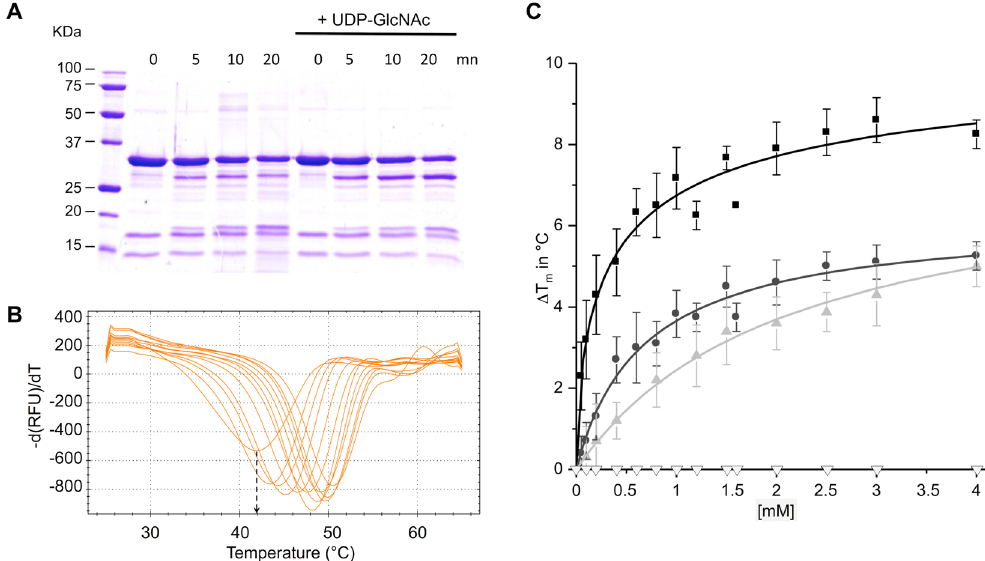
Figure 1. YvcK binds to UDP, UDP-Glc and UDP-GlcNAc. ( A ) Coomassie-stained SDS-PAGE of YvcK partial proteolysis profile. YvcK was incubated with Trypsin (Promega) in the absence or in the presence of 1 mM UDP- GlcNAc for 0, 5, 10 or 20 min at 37 °C. The digestion profiles were assessed by electrophoresis in 12.5% SDS- PAGE. Full-length gel is presented in Supplementary data. ( B ) Thermal Shift Assay (TSA) in the presence of increasing concentrations of UDP-GlcNAc. YvcK melting profiles were monitored in the presence of increasing concentration of UDP-GlcNAc (0 to 4 mM). One curve corresponds to data obtained for one concentration of UDP-GlcNAc. The melting temperature of the protein (T m ) is obtained at the midpoint of the each melting curve and corresponds to the minimum of the negative derivative curves (see the arrow that indicates the T m of YvcK in the absence of UDP-GlcNAc). The T m is an indicator of protein stability and is increased by the addition of UDP-GlcNAc (T m = 42 °C in the absence of UDP-GlcNAc and T m = 50.5 °C in the presence of 4 mM UDP-GlcNAc). ( C ) TSA results for the binding of UDP, UDP-Glc, UDP-GlcNAc and Glc-NAc. Assays were performed in the presence of increasing concentrations of ligands (0 to 4 mM). The difference of temperature (the shift of T m induced by the presence of ligand) was plotted against the concentration of UDP (black circle), UDP-Glc (grey triangle), UDP-GlcNAc (black square) and Glc-NAc (white triangle). All the curves correspond to the average of data from at least 3 independent experiments and the standard deviations are representated by the error bars. Curve fitting was performed by using Microcal Origin 5.0